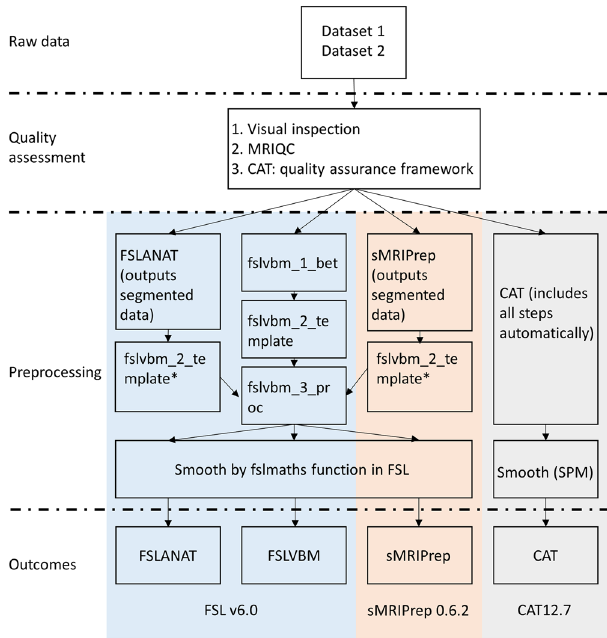
Fig. 1 Overview fl owchart of preprocessing steps across four pipelines. *Given that FSLANAT and sMRIPrep pipelines are mainly used for segmenting GM, WM, and CSF data, the segmented GM outcomes (in native space) were subjected to preprocessing steps from fslvbm_2_template (except for segmentation) and fslvbm_3_proc to produce normalized and modulated GM